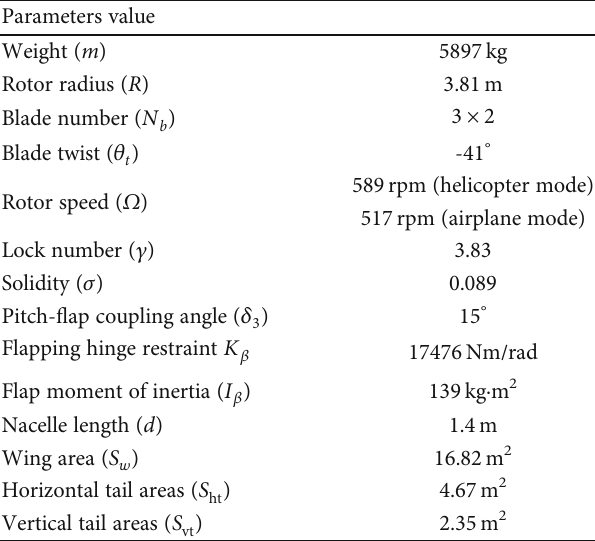
Figure 1: Tilt-rotor aircraft three fl ight Table 1: Basic parameters of XV-15 tilt-rotor.